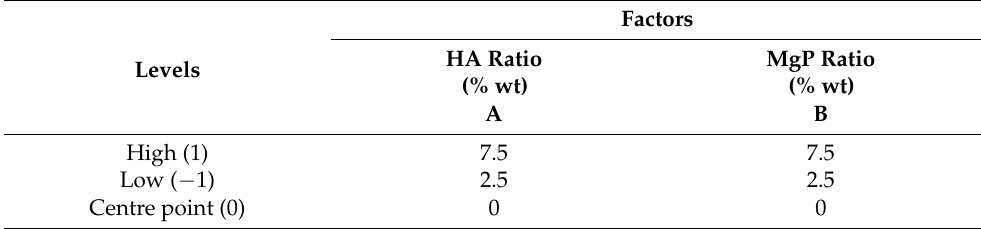
Table 1. HA and MgP ratio Factors and their levels.